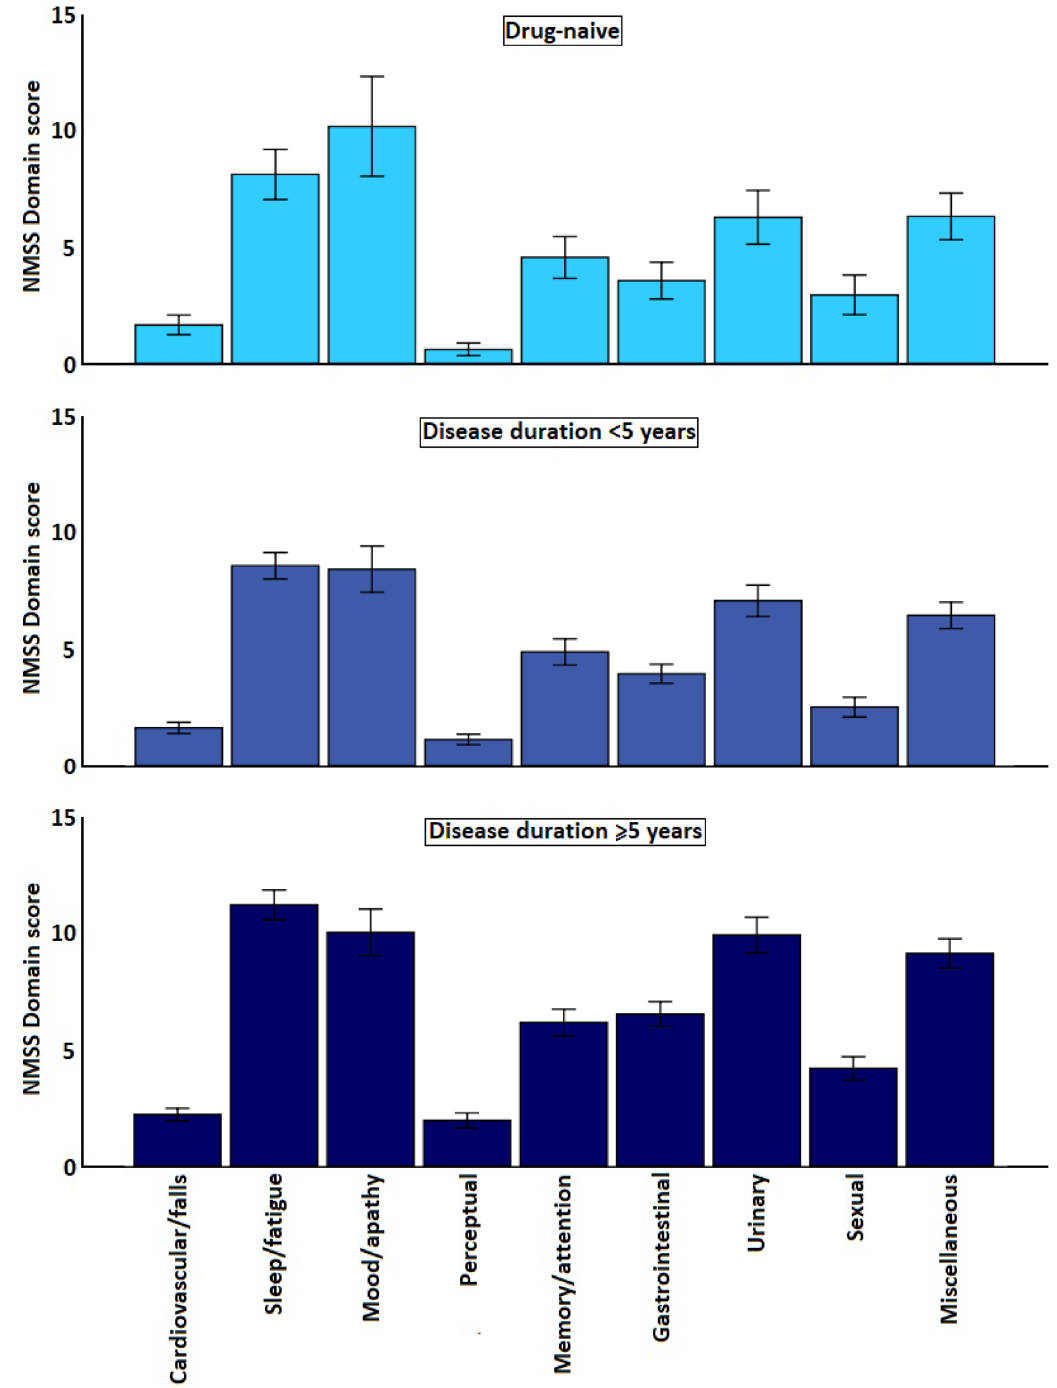
Figure 1. Distribution of specific non-motor domains of the Non Motor Symptoms Scale (NMSS) across drug-naïve and non-drug-naïve participants with Parkinson’s disease. Data presented as mean; bars represent the 95% confidence intervals. All NMSS domain scores were significantly higher in participants with a disease duration of ≥ 5 years compared to those with a duration < 5 years (p ≤ 0.016), but no domains between drug- naïve participants and those with a disease duration of < 5 years (p ≥